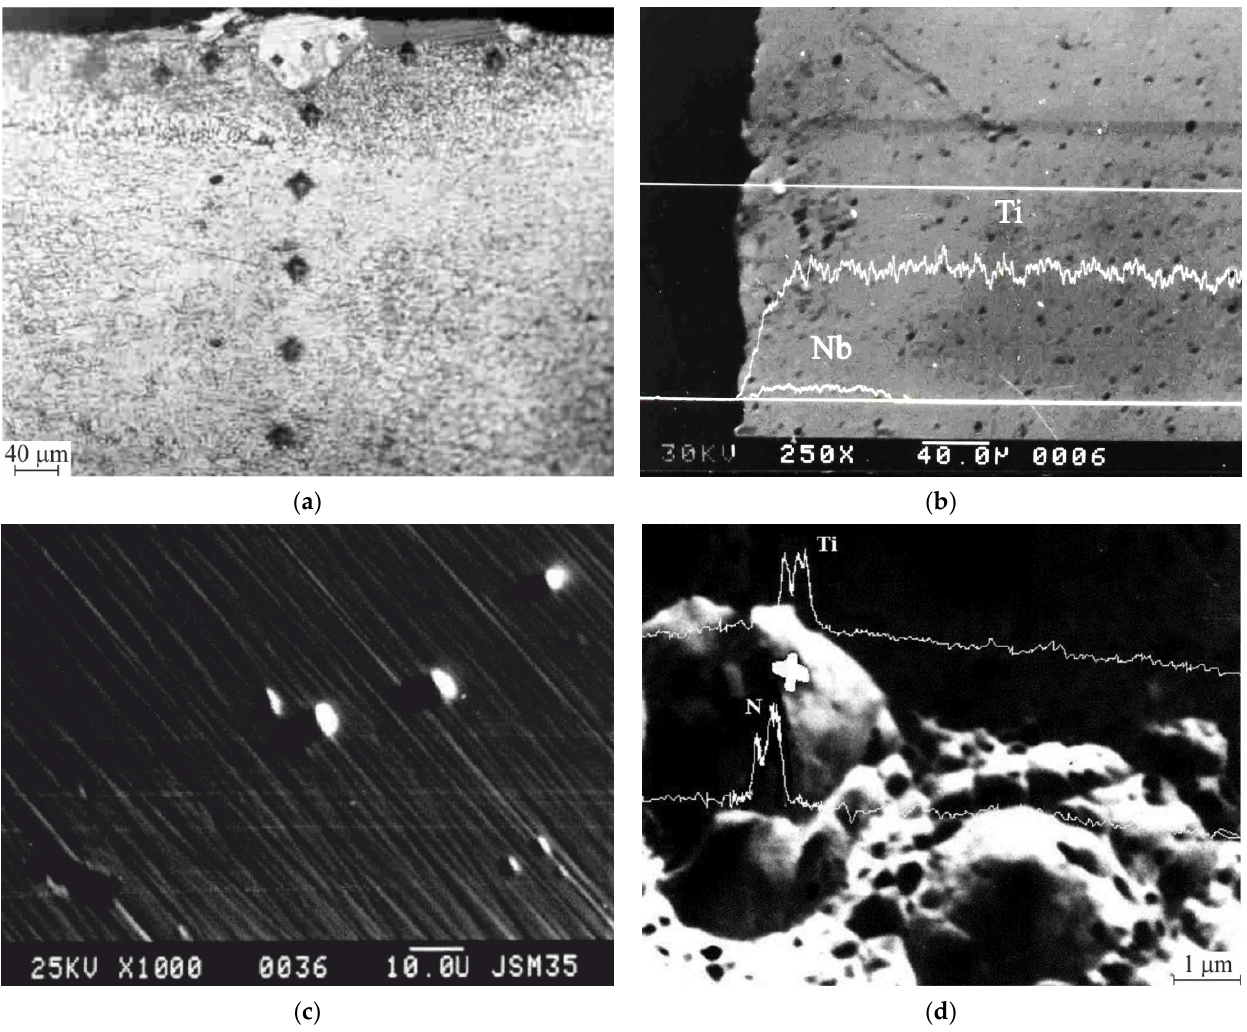
Figure 4. ( a ) Optical and ( b – d ) SEM images of AISI 304 steel after laser alloying with a plaster of 85Nb + 15% graphite with ( b , d ) EDS line scans showing distributions of ( b ) Ti, Nb and ( d ) Ti, N.